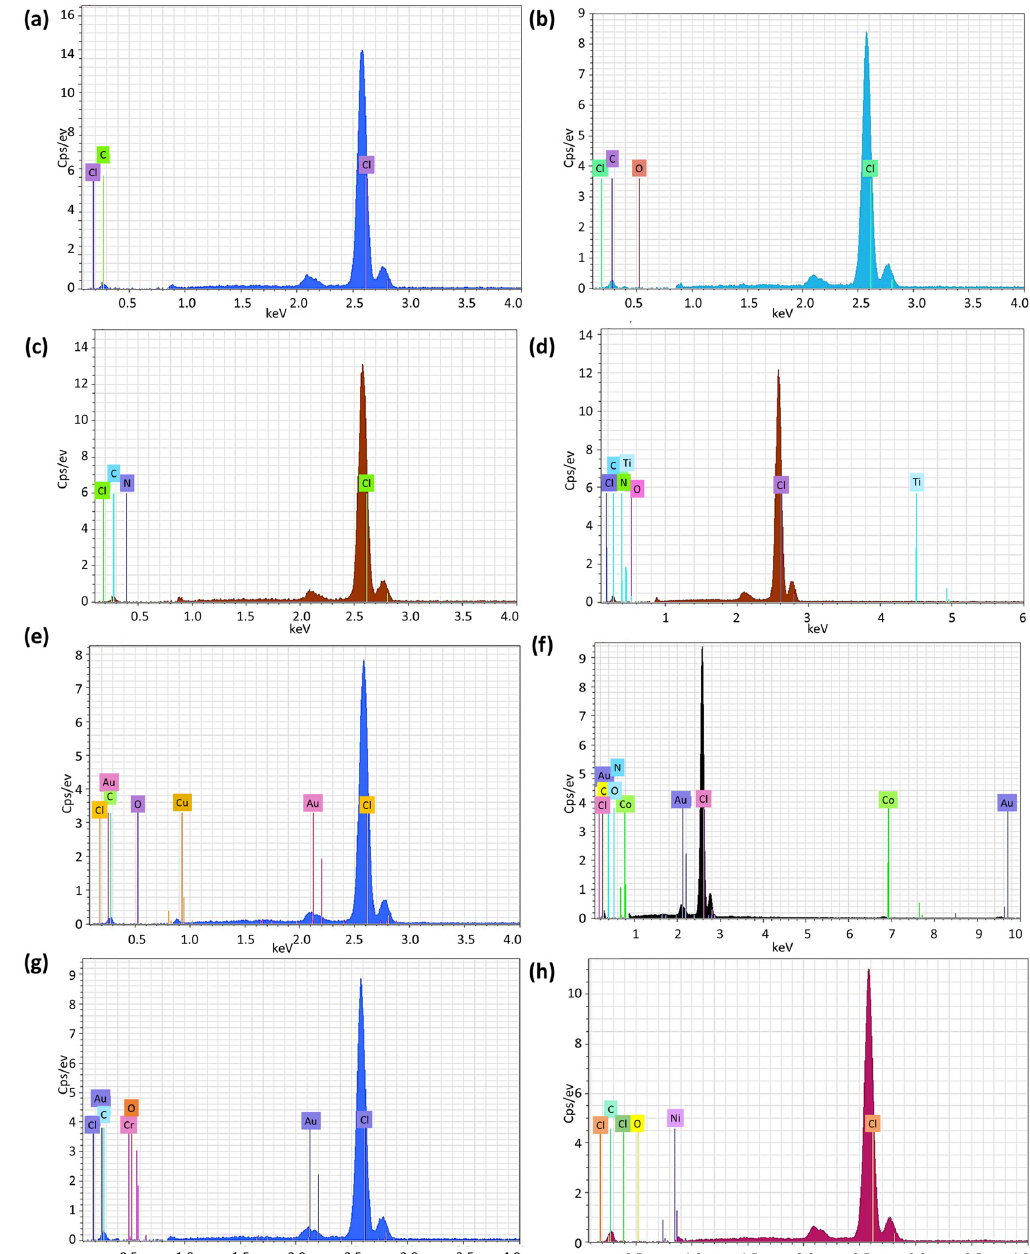
Figure 12. EDX images of PVC fi lms ( a ): pure PVC pre-irradiation, ( b ): pure PVC post-irradiation, ( c ): PVC/L post-irradiation, ( d ): PVC/L/Ti NPs post-irradiation, ( e ): PVC/L/Cu NPs post-irradiation, ( f ): PVC/L/Co NPs post-irradiation, ( g ) PVC/L/Cr NPs post-irradiation, and ( h ): PVC/L/Ni NPs fi lms post-irradiation.